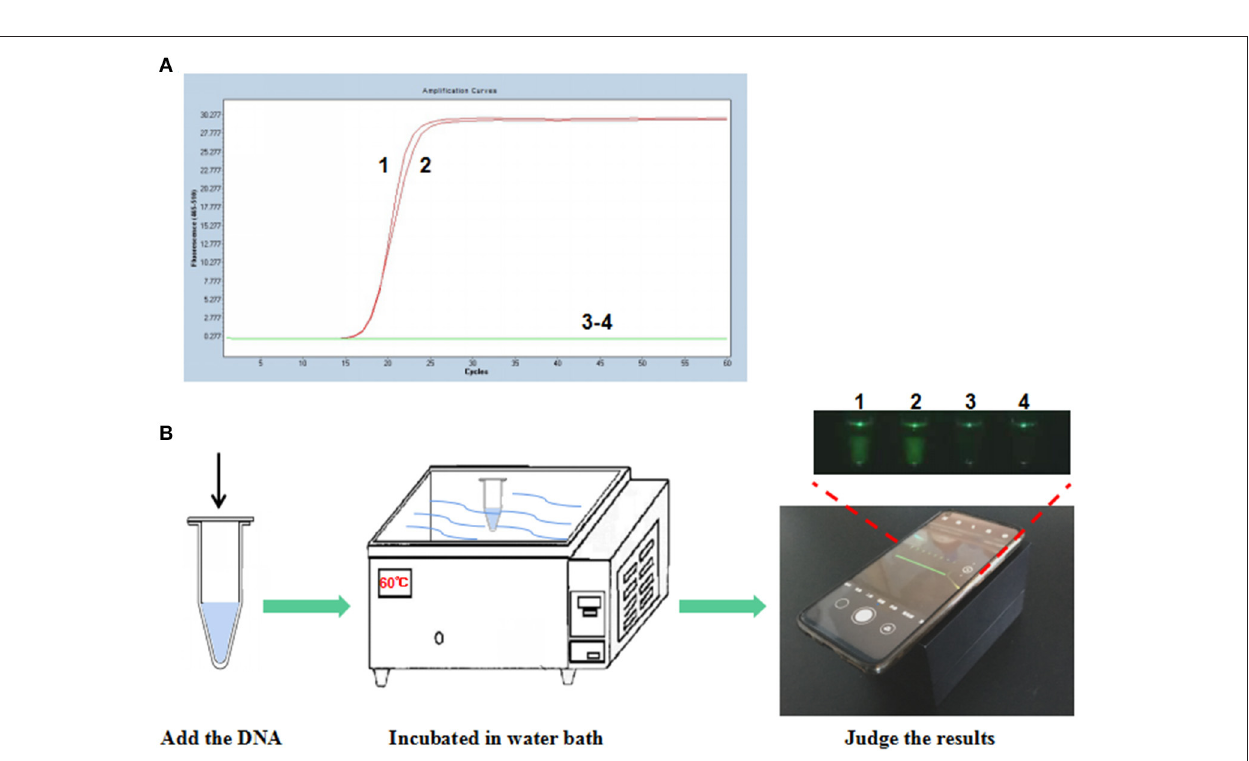
FIGURE 1 | Establishment of the P-S-MCDA assay for PCV3. (A) P-S-MCDA method assay by the Roche Light Cycler 480 II. (B) Flowchart of the P-S-MCDA method combined with smartphone-based cassette. Lanes or Tubes 1–2, 10 5 copies of pMD19T-capsid plasmid DNA. Lanes or Tubes 3–4, ddH 2